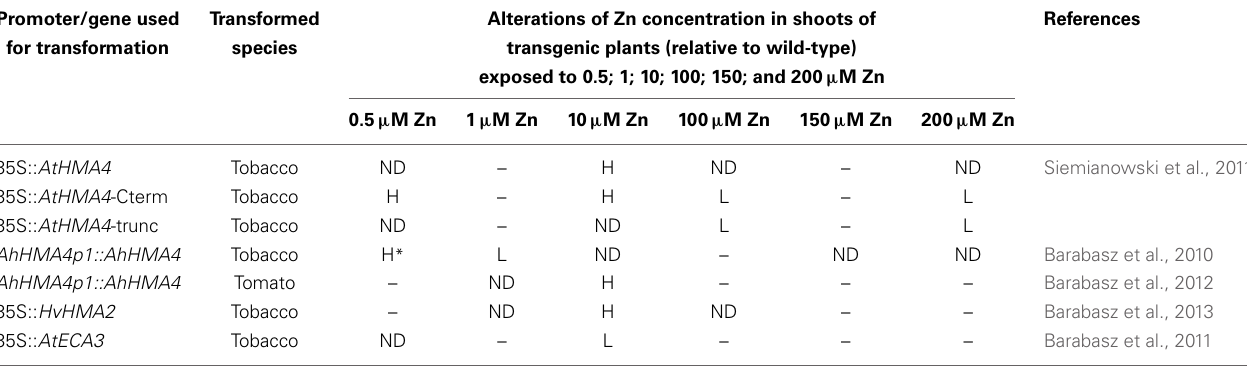
Table 2 | Zn-supply dependent modifications of Zn concentration in the shoots of plants expressing genes listed in the first column (relative to